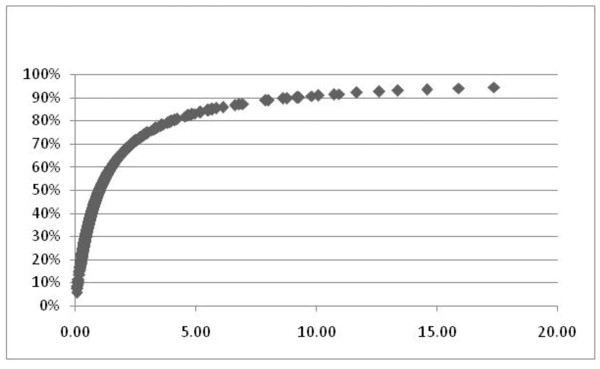
Probability curve for high cost hospitalization versus the linear regression calculation for age and select blood chemistry values. Probability for Hospitalization versus the linear progression for age, serum levels for hemoglobin, albumin, creatinine, alanine aminotransaminase, and e-GFR.